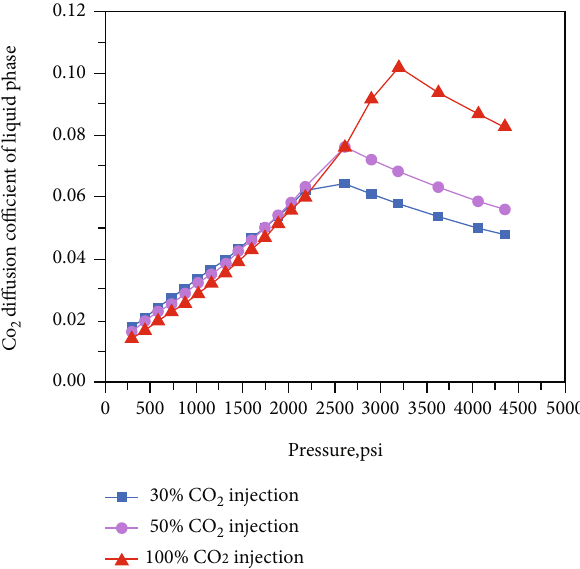
Figure 18: CO di ff usion coe ffi cient of liquid phase for the Bakken 2 tight oil versus pressure at various CO injection at T = 230 ° F. 2